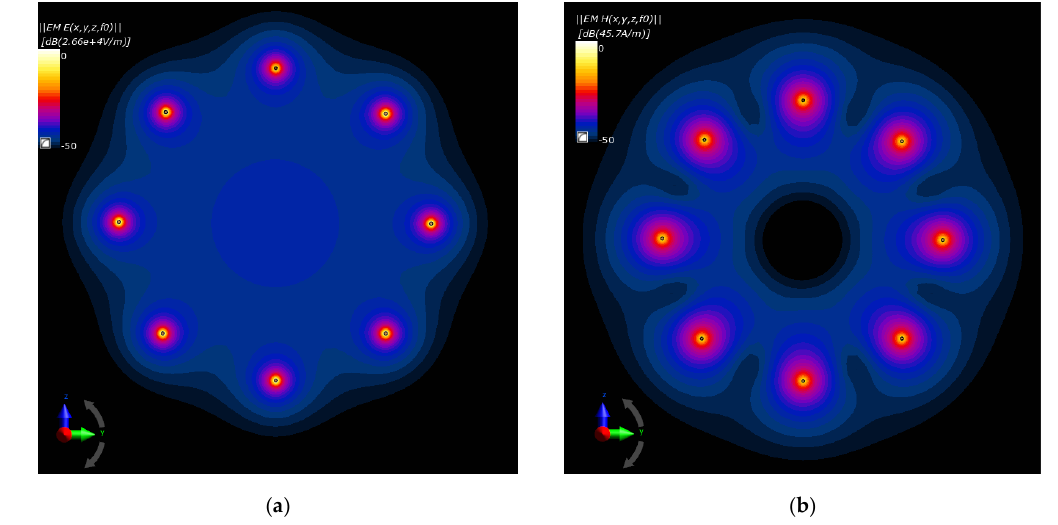
Figure 16. Normalized electric and magnetic field distributions from the antenna array when each dipole is working at f = 1 GHz and P i = 1 W before the optimization procedure: ( a ) E -field; ( b ) H -field.